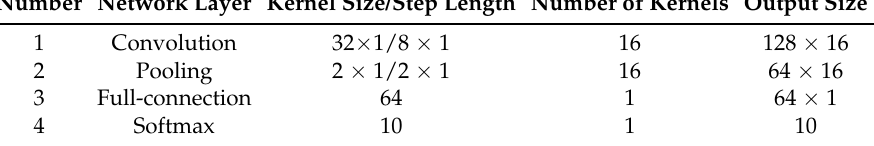
Table 4. Parameters of the 1D-SCNN model.